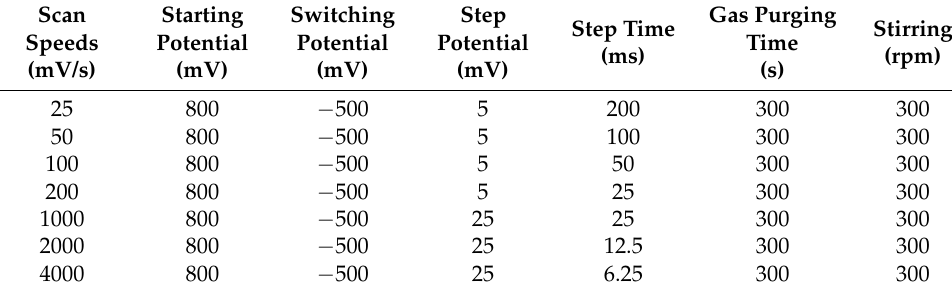
Table 2. Conditions used for cyclic voltammetry